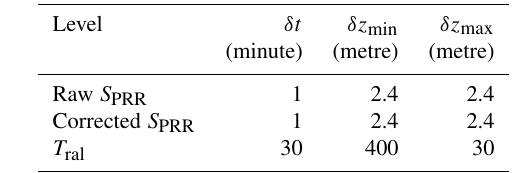
Table 3. Spatial and temporal resolution of S PRR signals and T ral